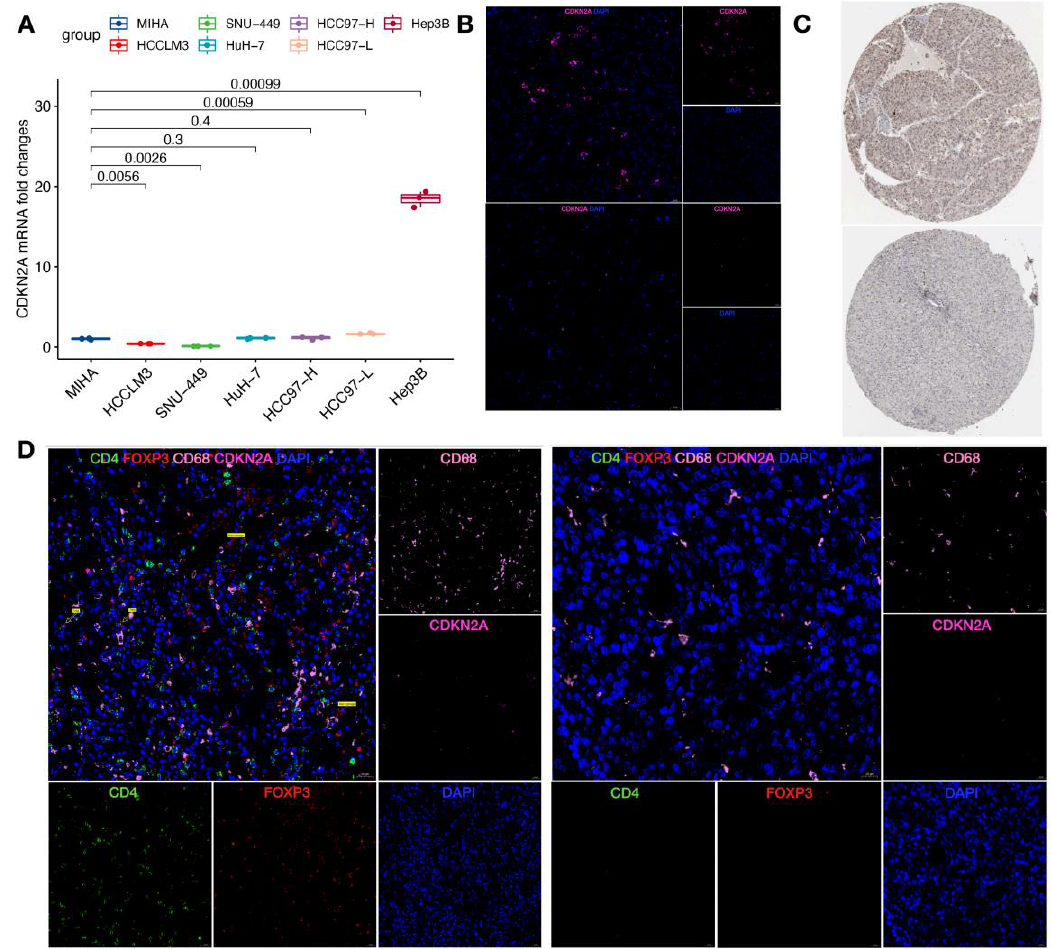
Figure 9. Validation of the CRGs and immune cells. ( A ) The expression of CDKN2A between MIHA as a normal hepatocyte line and 6 HCC cell lines was analyzed by qRT-PCR. ( B ) Two-color immunofluorescence results showed that CDKN2A was highly expressed in tumor tissues (upper panel) compared with non-tumor tissues (lower panel). ( C ) immunohistochemistry in the HPA showed a difference in CDKN2A expression in HCC (upper panel) and non-cancer issues (lower panel). ( D ) Multicolor immunofluorescence confirmed that the concentration of Treg and macrophages with a high-risk group (left panel) was higher than that in the low-risk group (right panel).